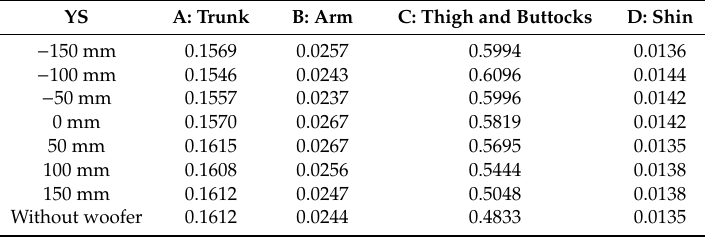
Table 6. Maximum electric field strength (V / m) variation in di ff erent measurement positions with the y -direction-adjusted woofer in the CFRP vehicle (XS =